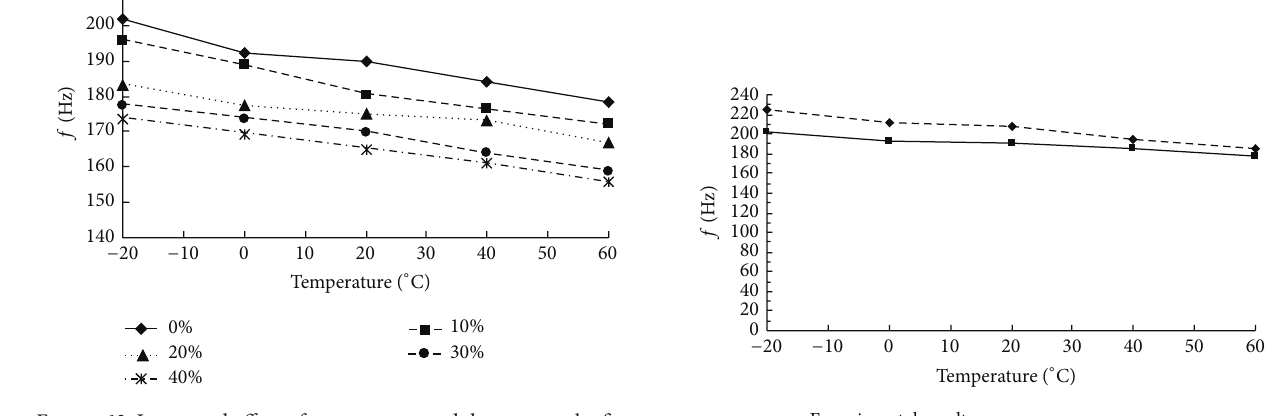
Figure 14: Integrated effect of temperature and damage on change rate of natural frequency.